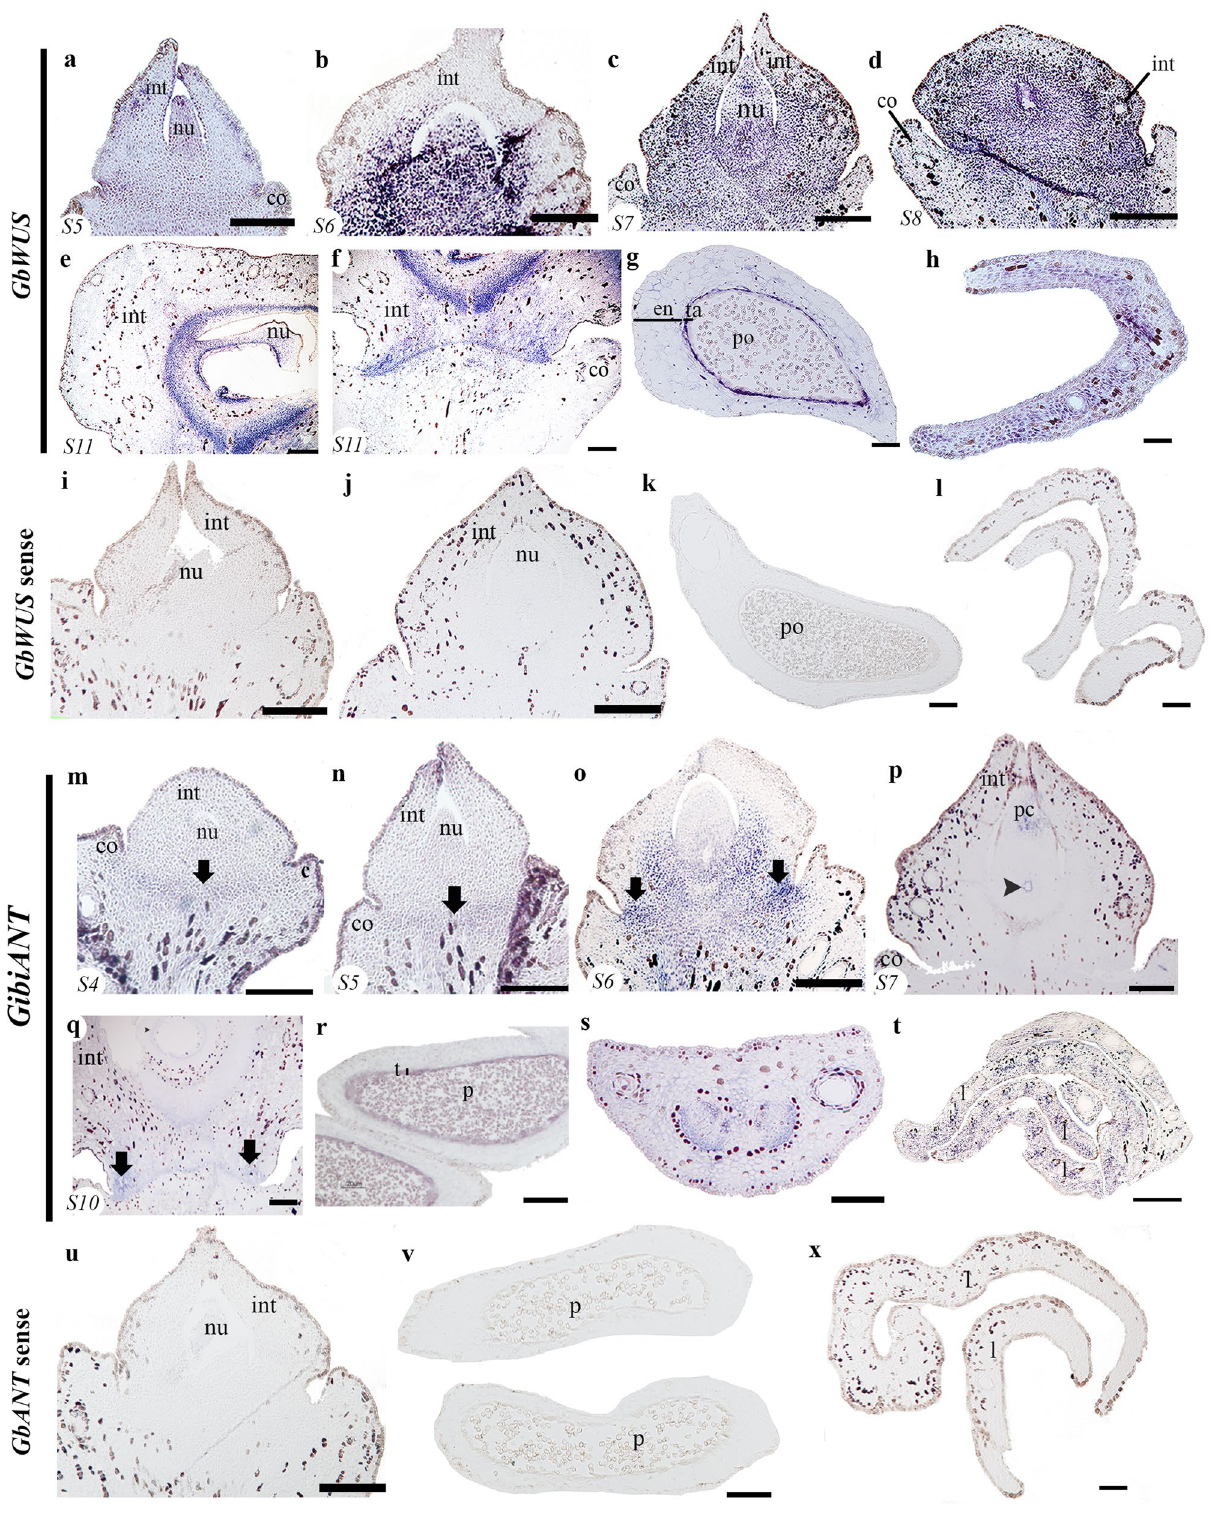
Figure 1. Expression of GibiWUS and GibiANT using in situ hybridization. ( a–h) GibiWUS expression patterns. (a) Ovule in stage 5 (S5). (b) Ovule in stage 6 (S6). (c) Ovule in stage 7 (S7), pollination stage. (d) Ovule in stage 8 (S8). (e) Ovule in stage 11 (S11). (f) Close-up of the abscission zone of the same ovule at stage 11 (S11). (g) Expression in the pollen cone. (h) Cross section of a leaf. (i–l ) GbWUS sense probe. ( m–t) GibiANT expression patterns. (m) Ovule in stage 4 (S4). (n) Ovule in stage 5 (S5). (o) Ovule in stage 6 (S6). (p) Ovule in stage 7 (S7). (q) Ovule in stage 10 (S10). (r) Microsporangium. (s) Petiole of the leaf. (t) Cross section of the leaf. ( u–x ) GbANT sense prone. The corresponding stage (S) is shown at the bottom left of each picture. Black arrows pointing to the abscission zone; black arrowheads pointing to the megaspore mother cell ; co collar, en endothelium, int integument, nu nucellus, po pollen, ta tapetum. Scales: 50 μm ( a,e–n,q,r ); 75 μm ( b,k,l,s,t ); 100 μm ( c,d